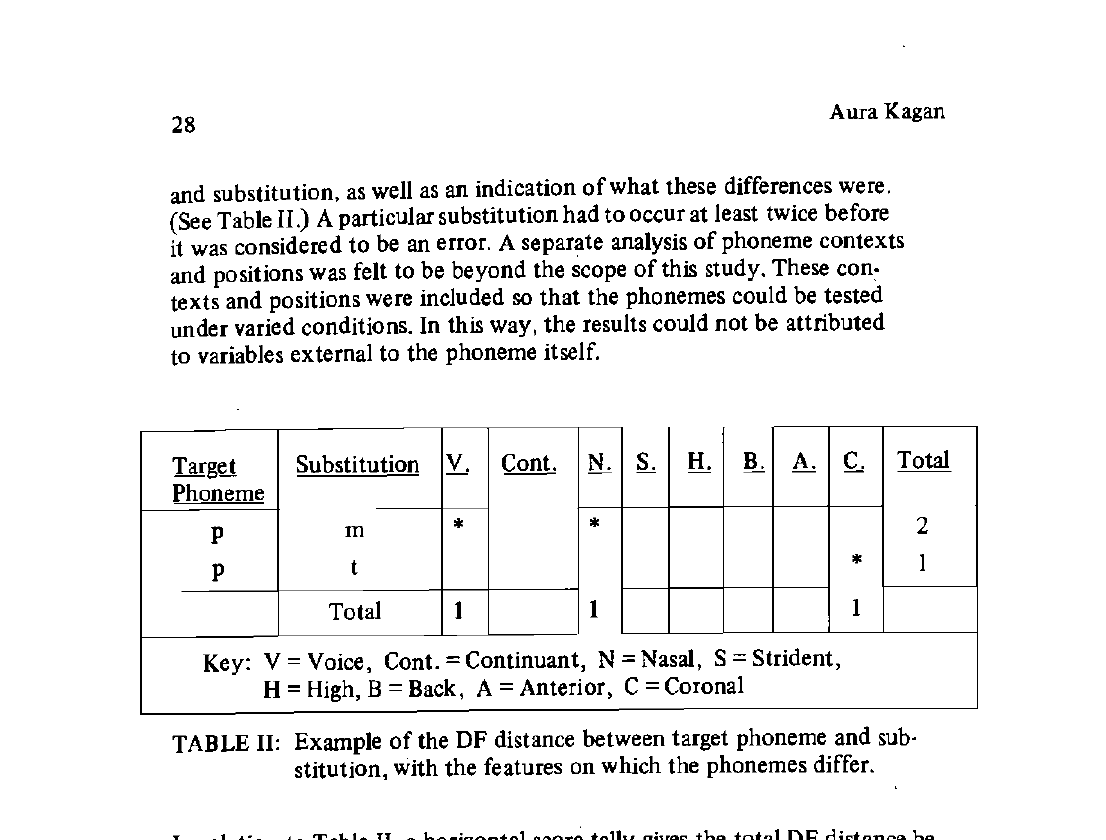
TABLE II: Example of the DF distance between target phoneme and sub- stitution, with the features on which the phonemes differ.